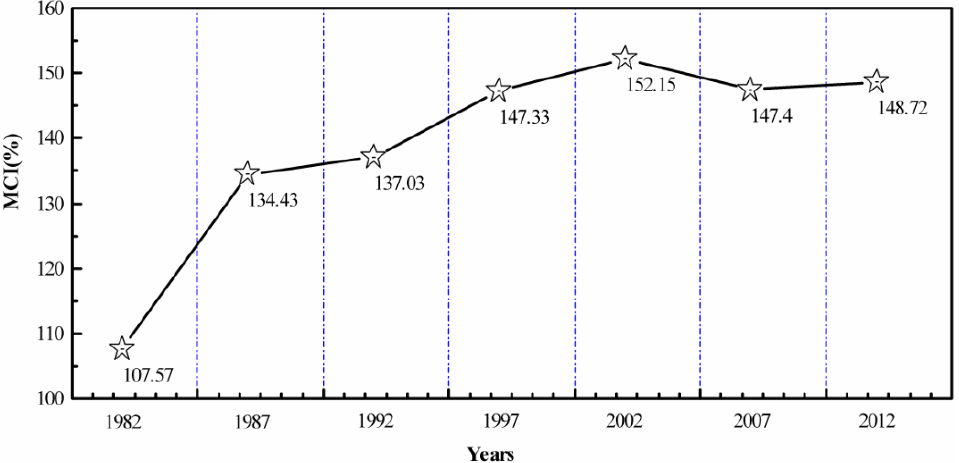
Figure 6. Variation tendency of the Multiple Cropping Indices in the North China Plain from 1982 to 2012.